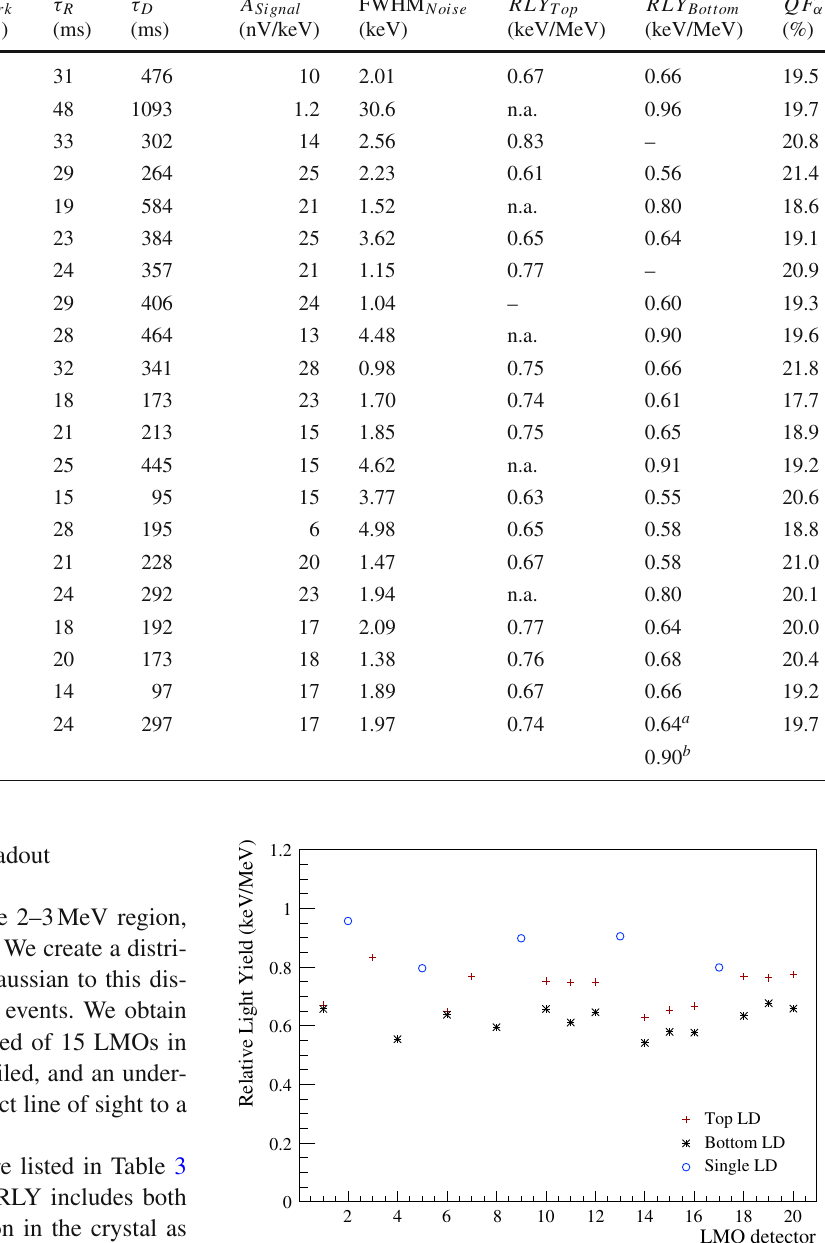
tion light yield (RLY) measured by top LD ( RLY Top ) and bottom LD ( RLY Bottom ), and the light yield quenching for alpha particles ( QF α ). The omission of a measured parameter due to lack of statistics or insuf- ficient performance/non-operational light detector is indicated by “–”. The median value for RLY Bottom is given for scintillators coupled to two LDs ( a ) and for single LD ( b ); see text